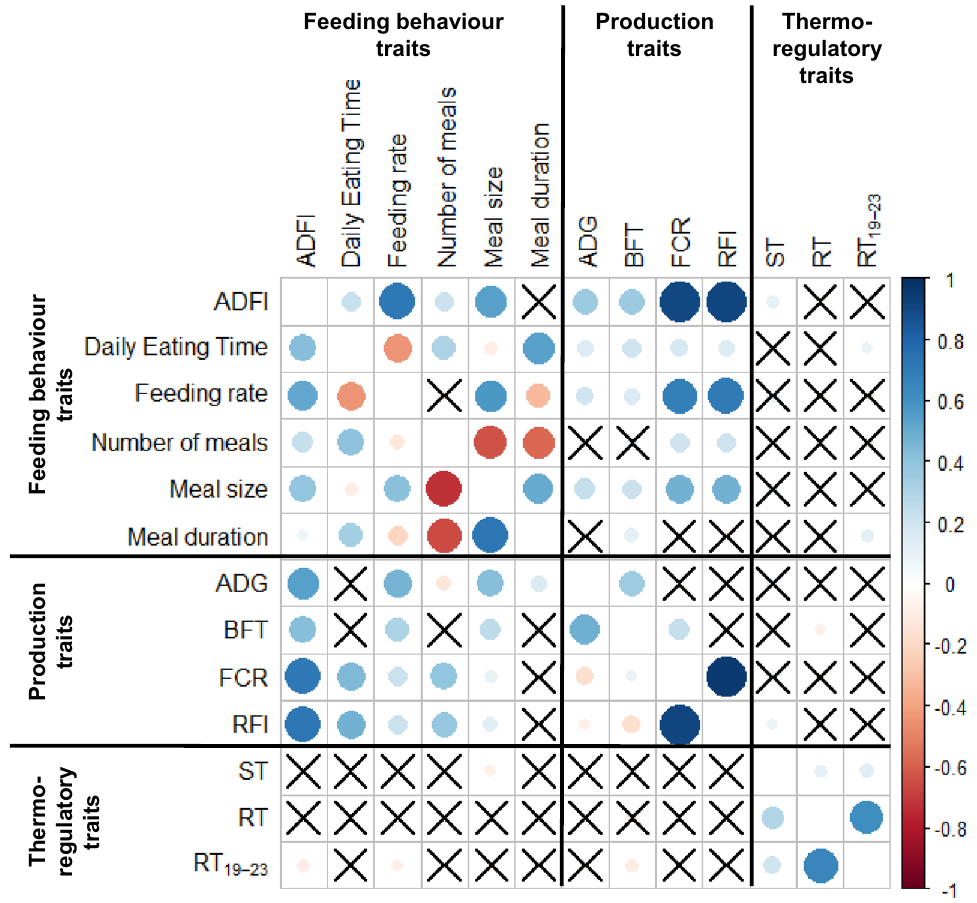
Figure 3. Pearson residual correlation plot between feeding behaviour and production traits. Above the diagonal: correlations between traits measured in temperate environment; below the diagonal: correlations between traits measured in tropical environment. The size of the circle is proportional to the absolute value of R coefficient of correlation of Pearson. The significance of correlation is P < 0.05 (Pearson correlation test) and the crosses indicate non-significant P values (P > 0.05). ADFI = Average Daily Feed Intake, ADG = Average Daily Gain between 11 and 23 weeks of age, BFT = Backfat Thickness at 23 week of age, FCR = Feed Conversion Ratio between 11 and 23 weeks of age, RFI = Residual Feed Intake between 11 and 23 weeks of age, ST = Skin Temperature, RT = Rectal